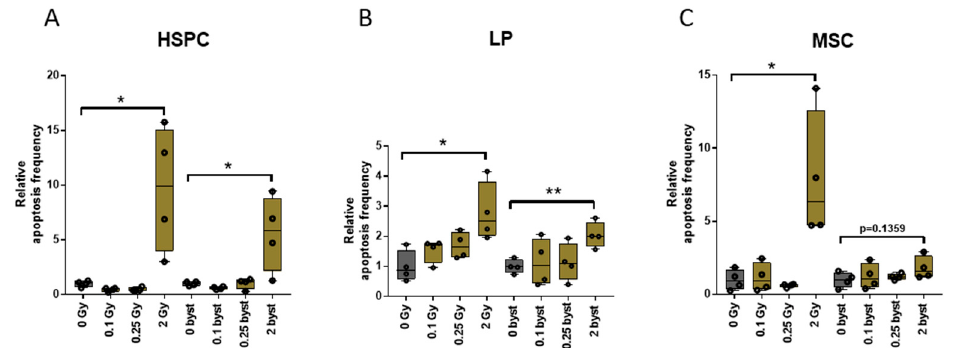
Figure 9. Transfer of Bone Marrow-Derived Extracellular Vesicles from Irradiated Mice Is Able to Induce Apoptosis in a Bystander Manner in Hematopoietic Stem Cells and Lymphoid Progenitors but Not Mesenchymal Stromal Cells. Bone-marrow single-cell suspension was prepared from directly irradiated and extracellular vesicle-treated mice 4 h after treatment and apoptosis was measured by the Tunnel assay as described in the Materials and Methods section. The relative change in apoptosis frequency compared to control mice (either non-irradiated or treated with extracellular vesicles originating from the bone marrow of non-irradiated mice) is shown for hematopoietic stem and progenitor cells ( A ), lymphoid progenitors ( B ) and mesenchymal stromal cells ( C ). Mean, minimum and maximum values are shown, error bars represent SD. n = 4, significance tested by Student’s t -test, p * < 0.05; p ** < 0.01.